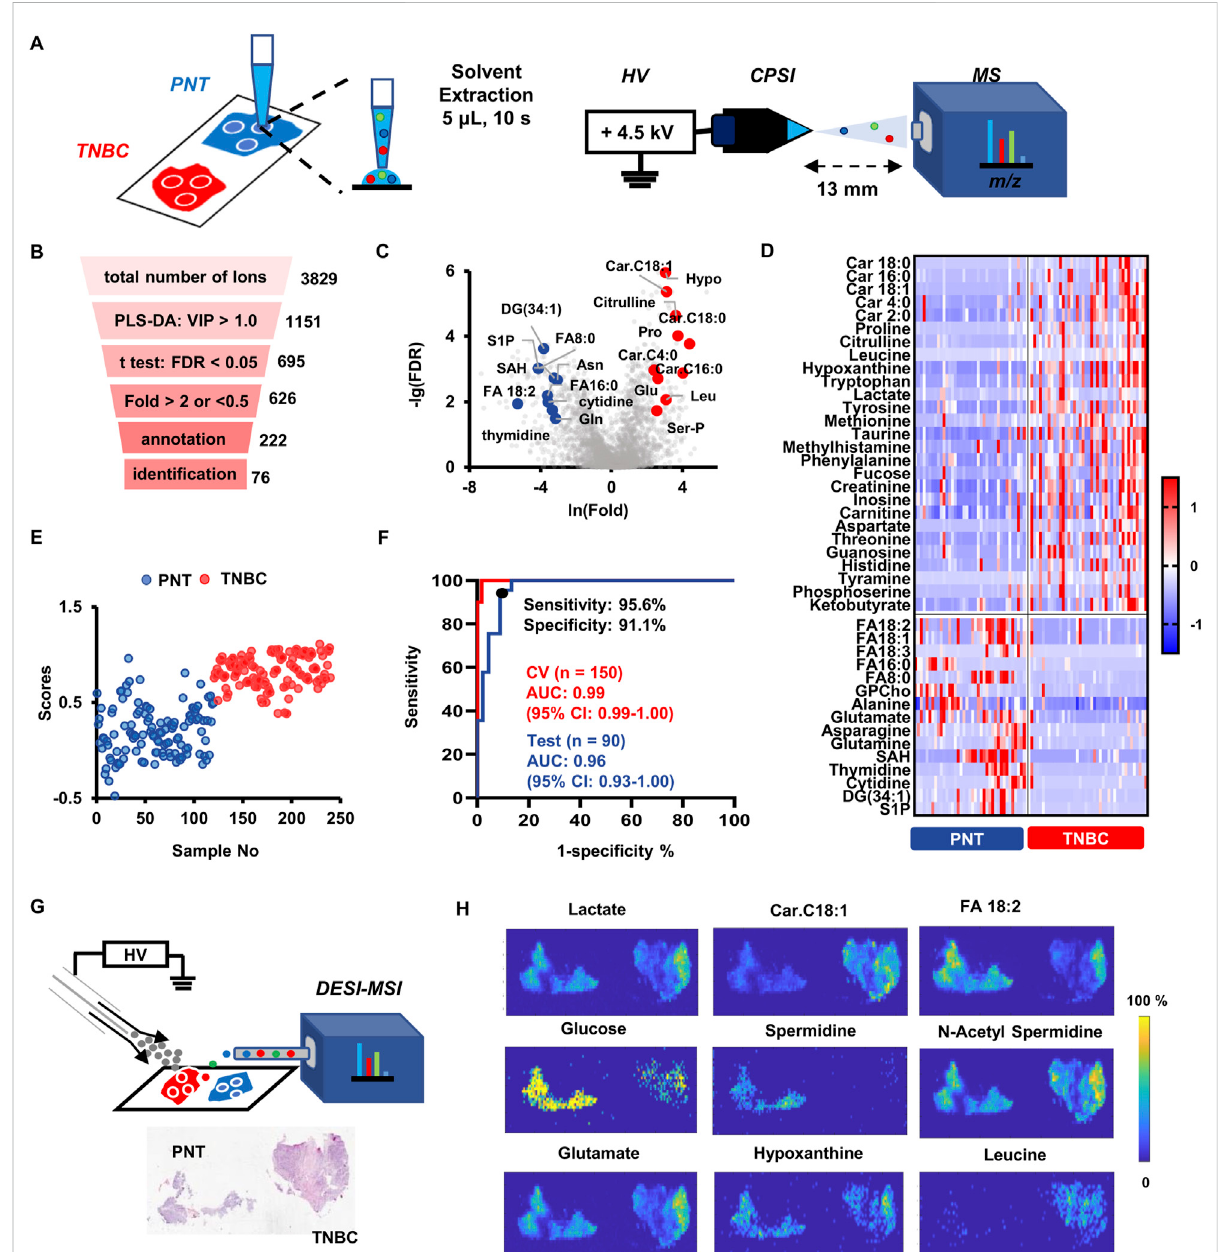
FIGURE 2 TNBCtissuemetabolic fi ngerprinting,machinelearning-basedmoleculardiagnosisand insitu validationbyDESI-MSI. (A) Diagramillustrationof the droplet-extraction-based CPSI-MS data collection for the biopsied tissue. Metabolites derived of three different sampling points are collected from each tissue. (B) The stepwise statistical pipeline for fi nally preserving the metabolites that have signi fi cant changes in TNBC compared to PNT specimens. (C) The volcano plot highlighted those metabolite ions that have signi fi cance (FDR < 0.05) in fold change over 2.0 or less than 0.5 in TNBCs compared to PNTs. (D) Heatmap visualizes the relative expression level of the 40 representative characteristic metabolites in TNBCs and PNTs. (E) Plotofall240tissuepointsscorespredictedbytheLassoclassi fi er. (F) ROCcurvesforevaluatingtheLassomodel ’ sdiagnosticperformance on training and test set. (G) Diagram illustration of the employed DESI-MSI setup for visualizing metabolite ’ s distribution across a paired TNBC/PNT tissue cryosections. (H) Images of representative metabolites that are signi fi cantly changed in TNBCs compared to